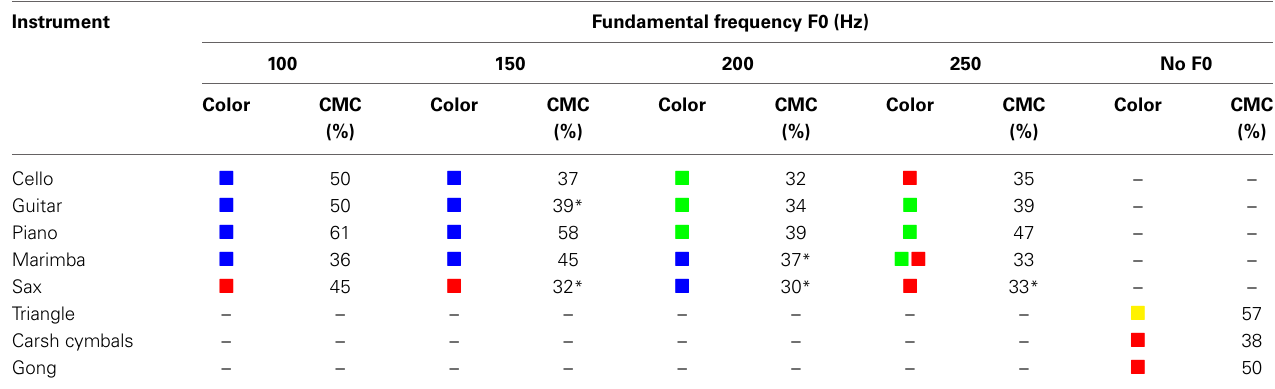
Table 2 | Color selections for timbre: this table shows the color selected for each sound.